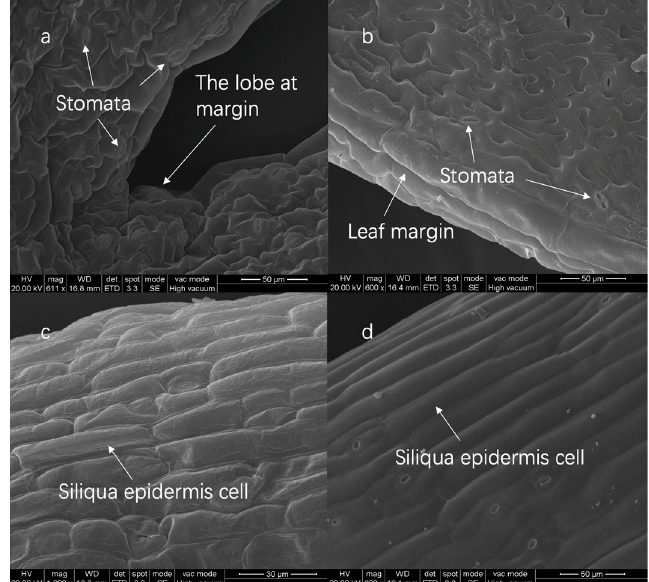
Figure 3. The SEM imaging leaf margin and siliqua epidermis. ( a ) 35S::LcKNOX6 leaf lobe at the